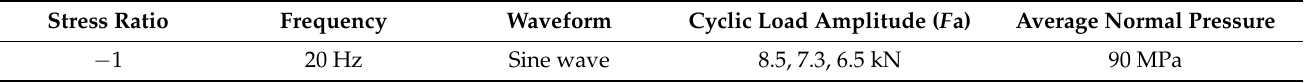
Table 2. Loading parameters of the fretting fatigue test in this work.